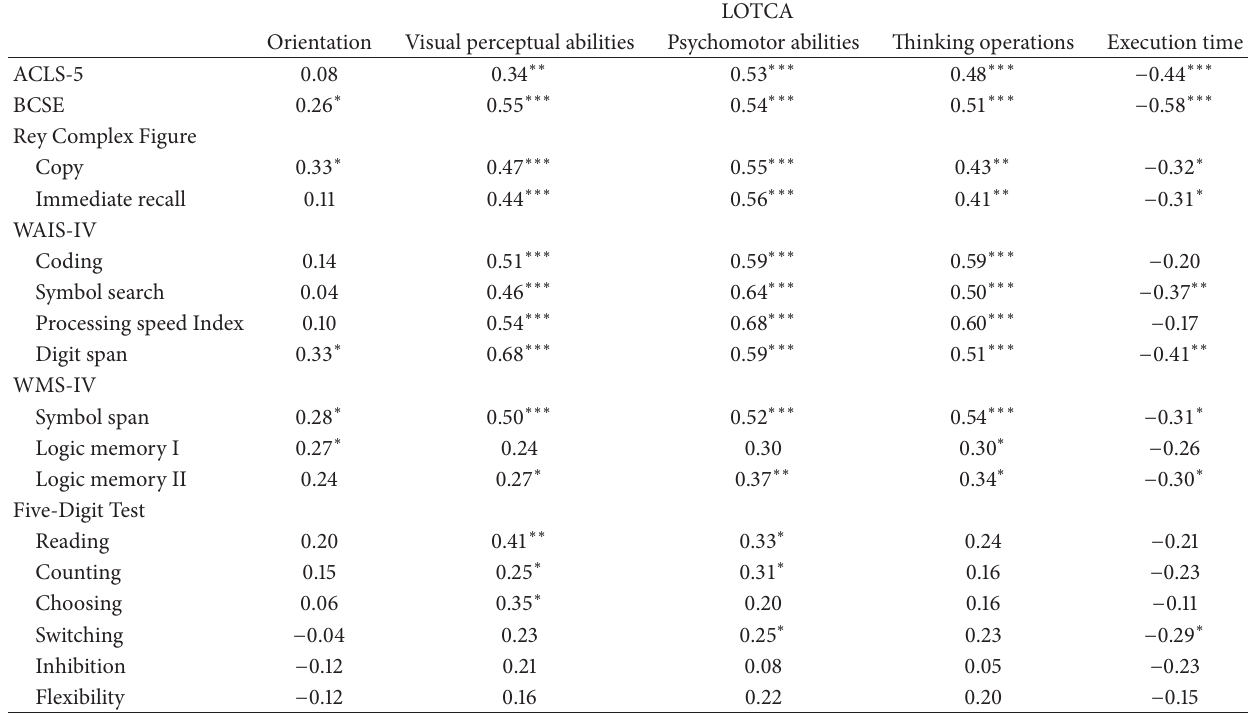
Table 3: Spearman correlations between the LOTCA scale scores and scale scores obtained with the neuropsychology battery of tests. LOTCA Orientation Visual perceptual